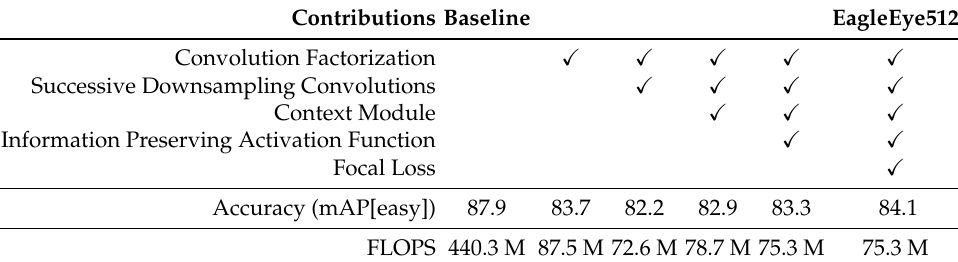
Table 3. Ablation study on wider face’s validation set.